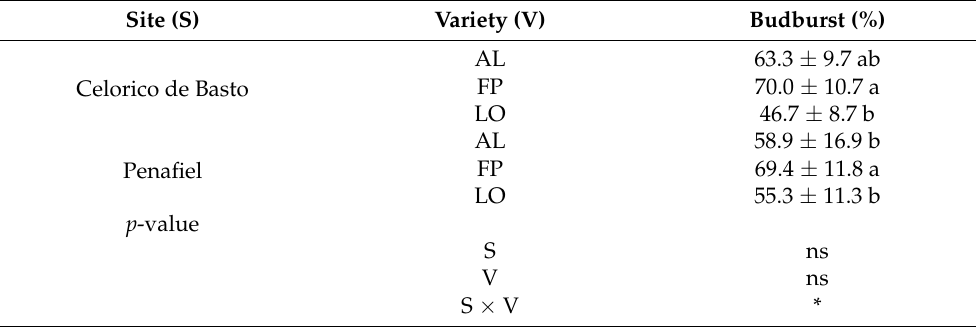
Table 1. Mean values of budburst percentage of Alvarinho (AL), Fern ã o-Pires (FP), and Loureiro (LO) varieties in Celorico de Basto and Penafiel vineyards obtained by forced bursting. The mean values followed by different letters are significantly different at p < 0.05 by Tukey’s HSD test. Different letters in the same column indicate significant differences. Site (S), variety (V), and interaction effects (S × V).